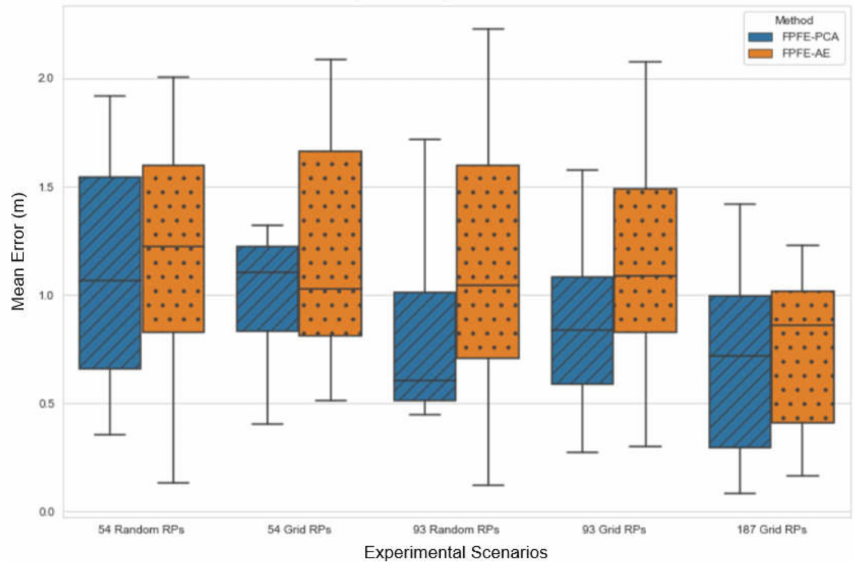
Figure 18. The localization error box and whisker plots of FPFE for different experimental scenarios with k = 7 RP candidates.